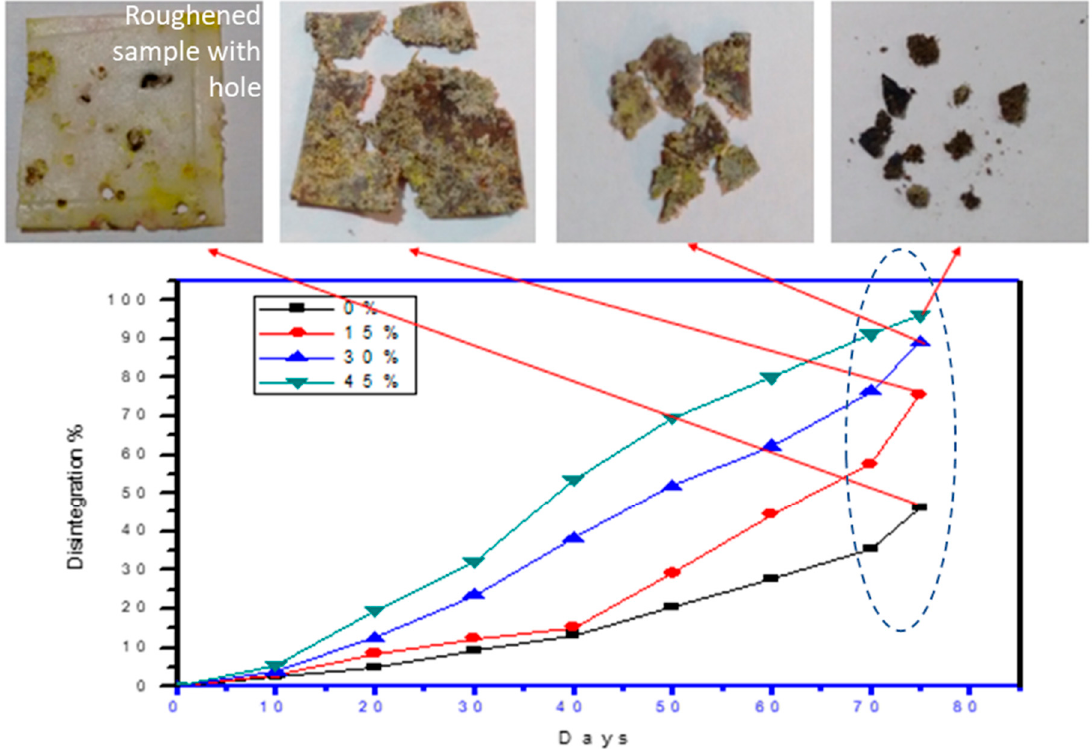
Figure 10. Bio-degradation test with 0, 15, 30, and 45 wt % of PCP.